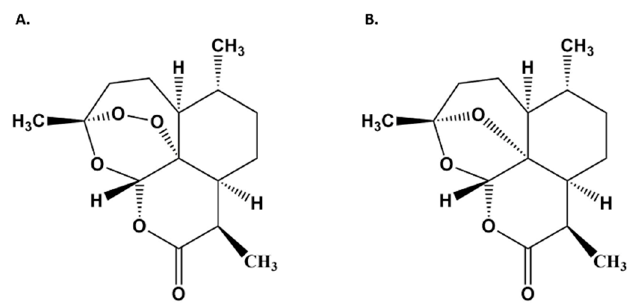
Figure 1. Chemical structures of artemisinin ( A ) and deoxyartemisinin ( B ).